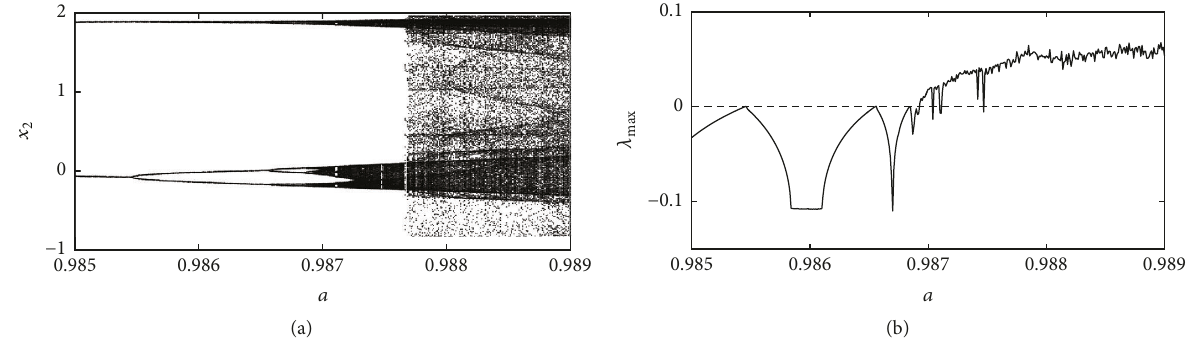
Figure 1: Bifurcation diagram of forced van der Pol oscillator for 𝜔 = 0.45 and 𝜂 = 1 using (a) Poincar´e map and (b) largest nonzero Lyapunov